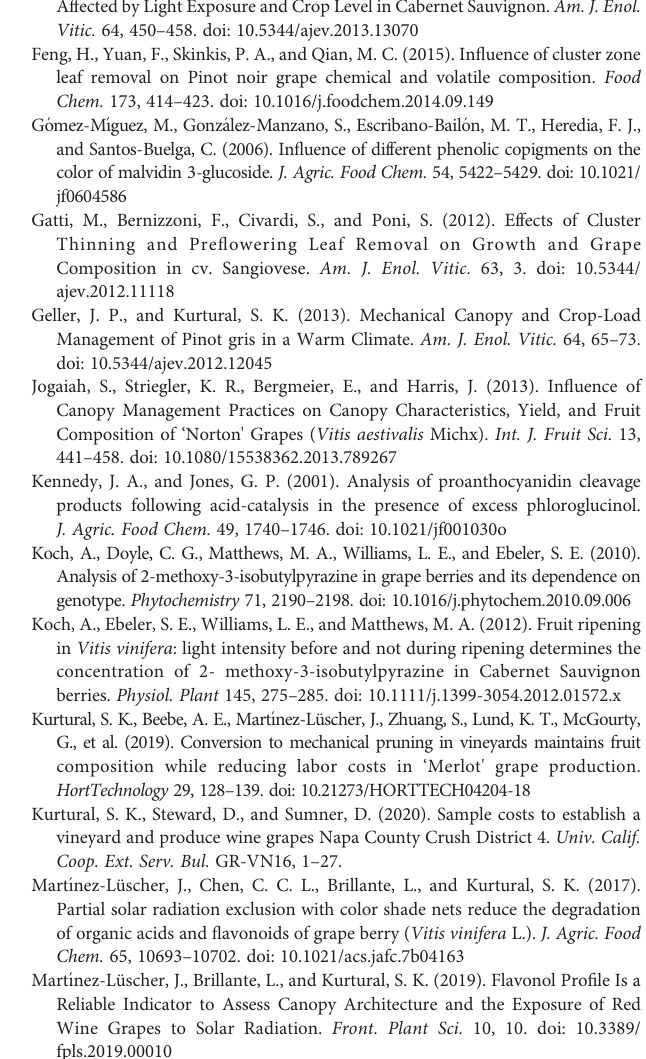
FIGURE S2 | Relationship between the % of Kaempferol and cluster temperature at mid ripening in Cabernet Sauvignon subjected to different canopy management